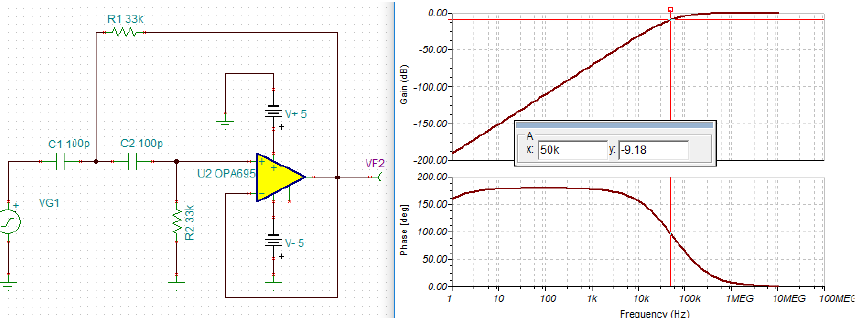
Fig. 7. Sallen-key high pass filter and ac transfer function using TINA-TI